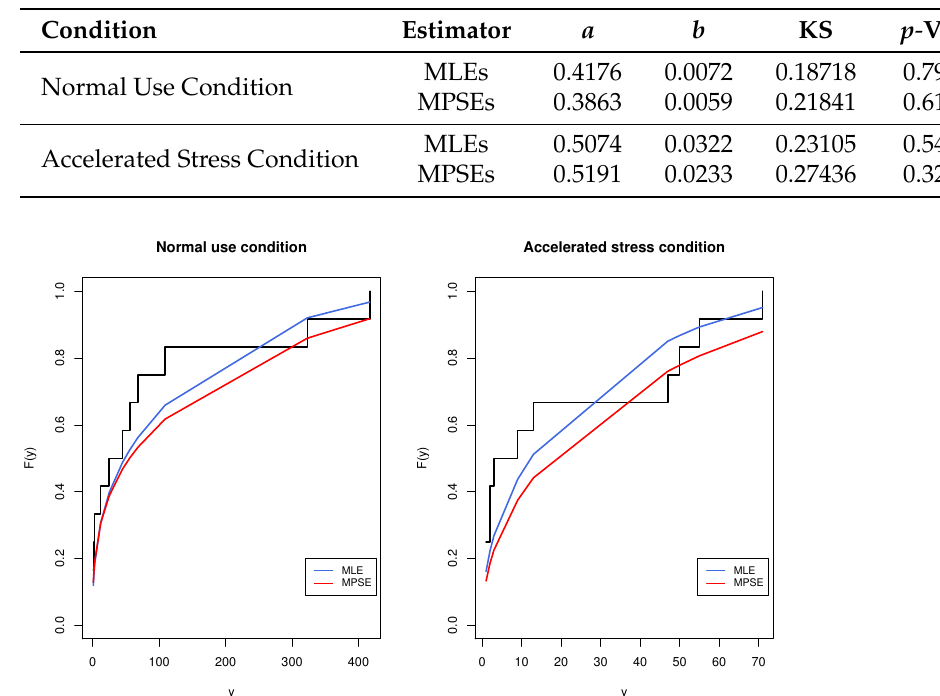
Table 9. The MLEs, MPSEs and K-S statistics with the associated p-values for the breakdown of steel, complete data.